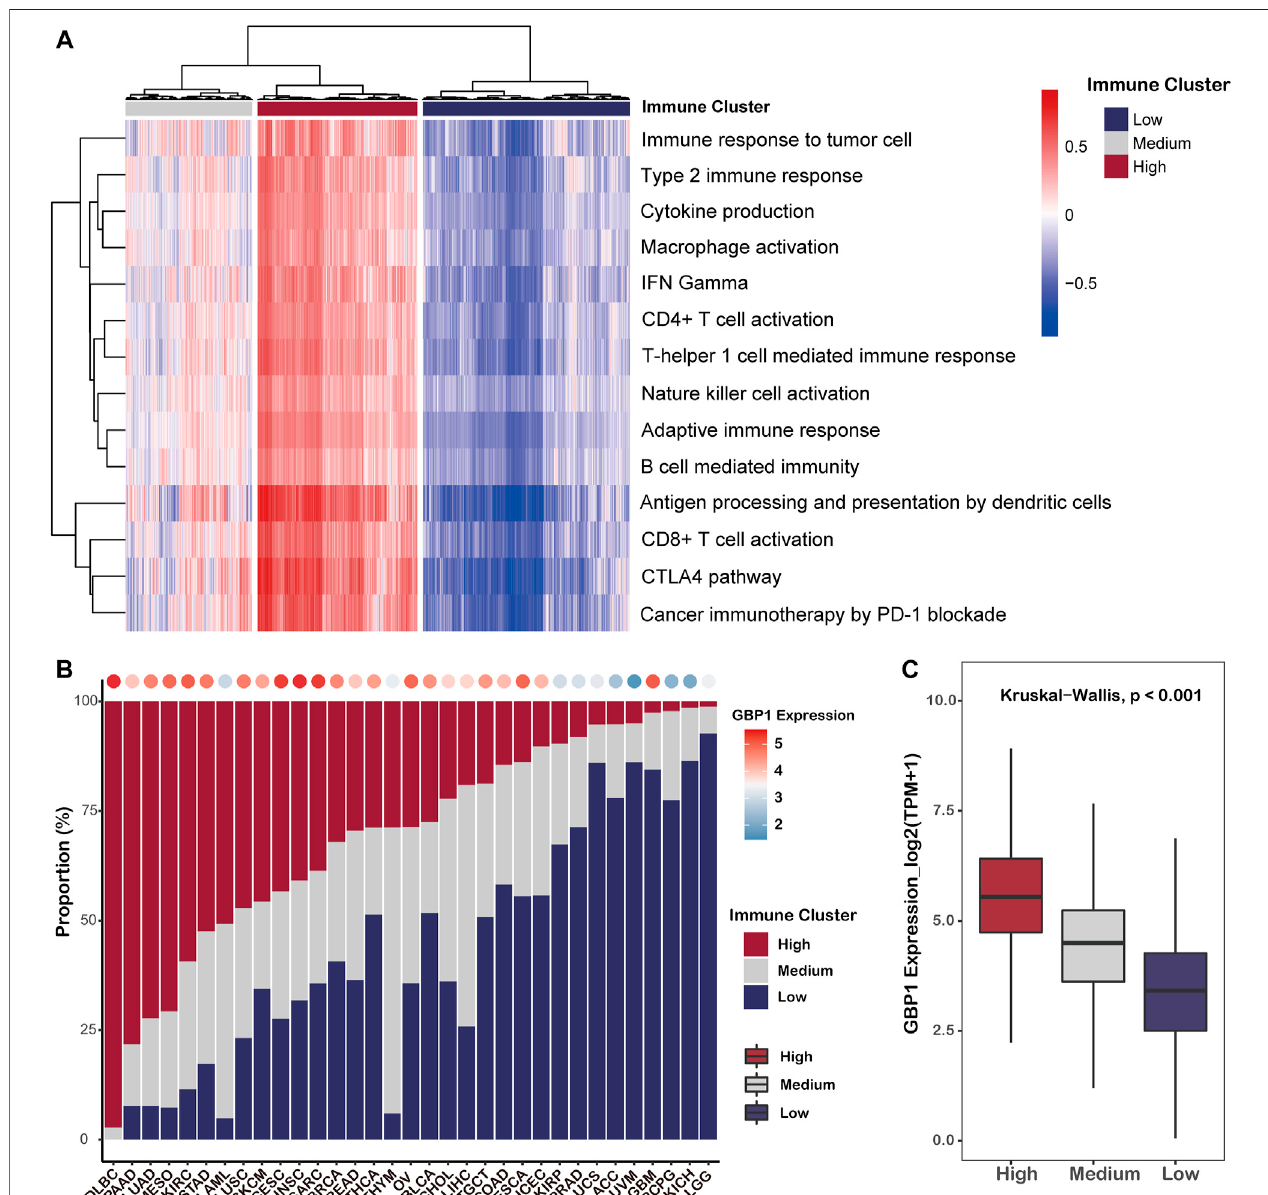
FIGURE 6 | Clustering of pan-cancer patients based on their anti-tumor phenotypes. (A) Heatmap showing the pan-cancer patients grouped by hierarchical clustering using the GSVA enrichment scores for 14 immune-related gene sets. Patients were clustered in three major groups de fi ned as low immune cluster (LIC), mediumimmunecluster(MIC),andhighimmunecluster(HIC). (B) Proportionofthreeimmuneclustersineachcancertype.Bubblesatthetopofthegraphrepresentthe correlationof theproportion ofHIC with average GBP1expression ineach cancer type. (C) Boxplotshowingthe expression level ofGBP1 ineach